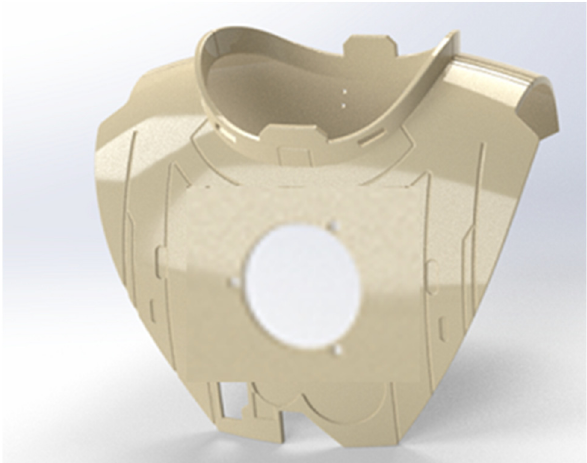
Figure 12. Complete armor diagram after restoration.